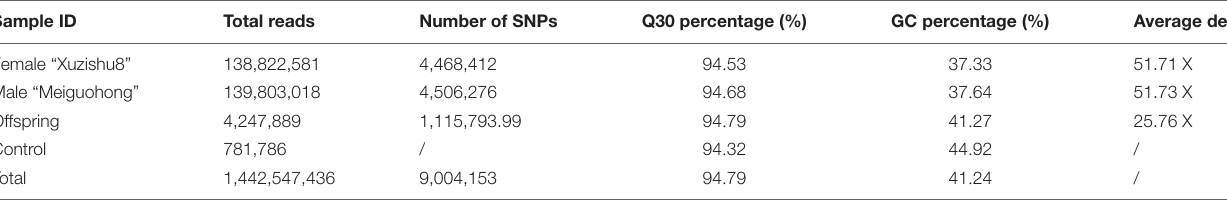
TABLE 2 | Summary of the sequencing data for the two parents and F1 progeny. Sample